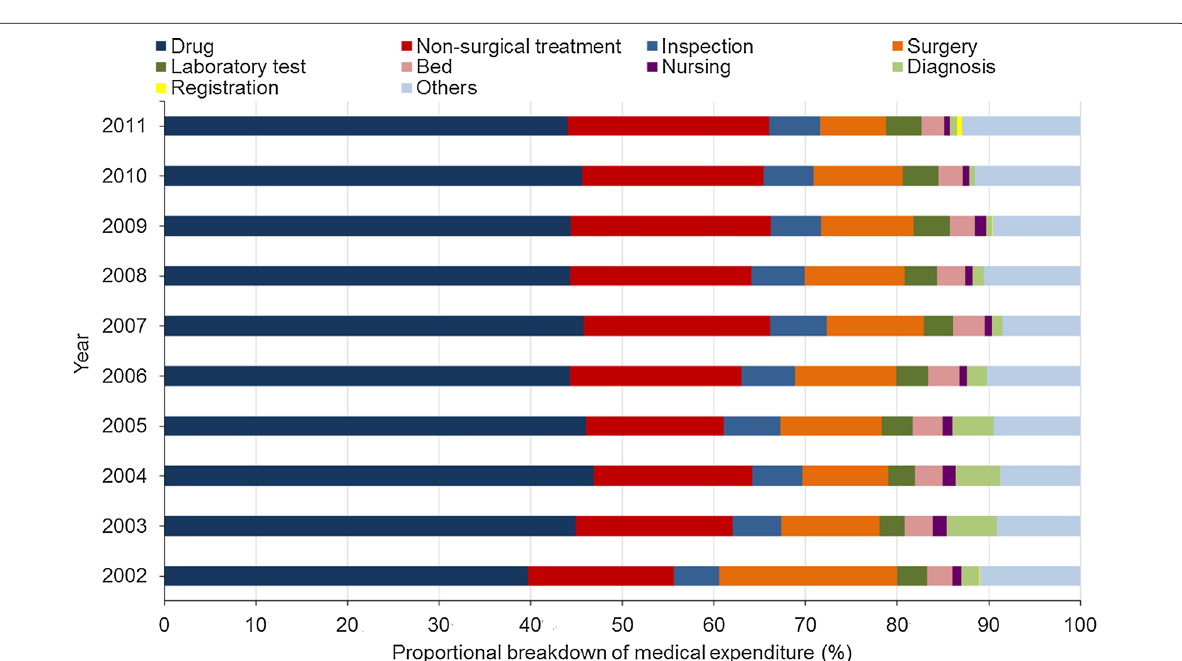
Fig. 4 The proportional breakdown of medical expenditures for esophageal cancer diagnosis and treatment per patient. Others include the expen‑ ditures for oxygen, blood infusion, heating, and